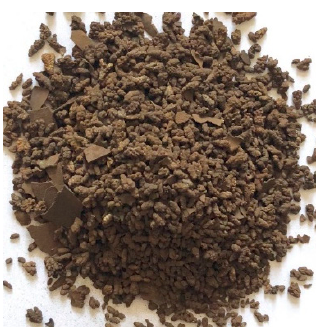
Figure 1. Rejected electrolytic manganese metal.